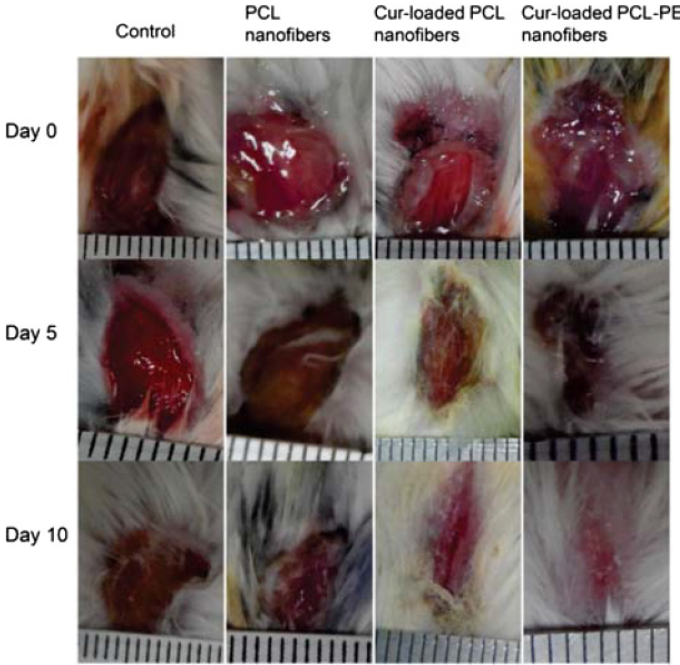
Fig. 3. Photograph of wound closure rate of mouse dorsal for nano¯bers treated on days 0, 5 and